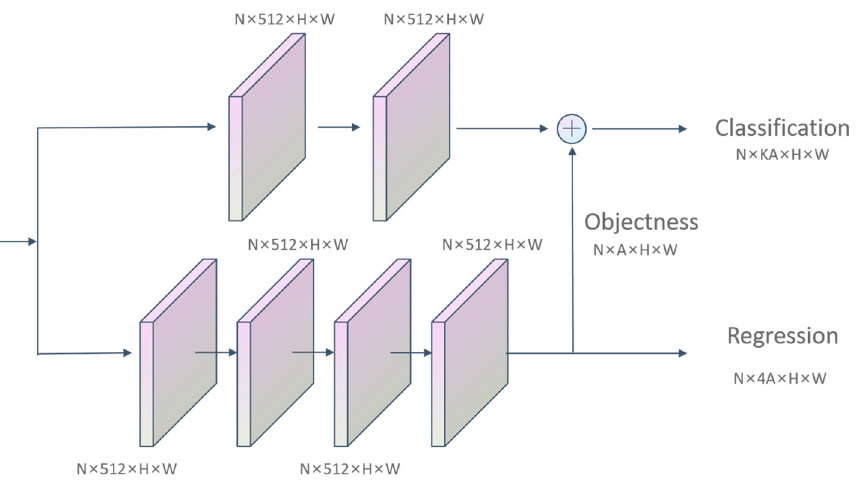
Figure 8. The classification and regression head with two and four convolution layers, respec- tively.